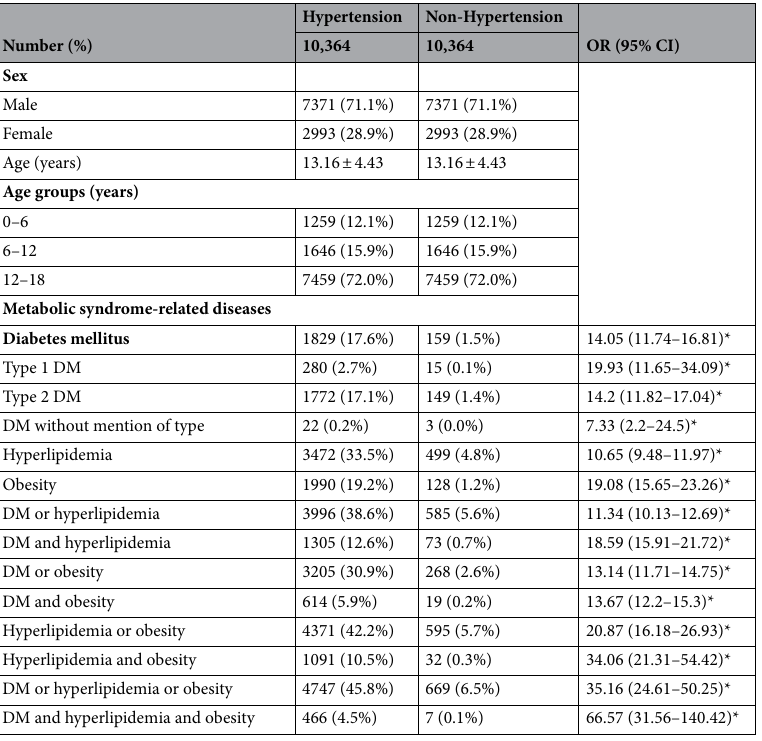
Table 2. Paired comparison of metabolic syndrome-related diseases in children and adolescents with hypertension and non-hypertension. CI confidence interval, DM diabetes mellitus, OR odds ratio, SD standard deviation. * p < 0.001.